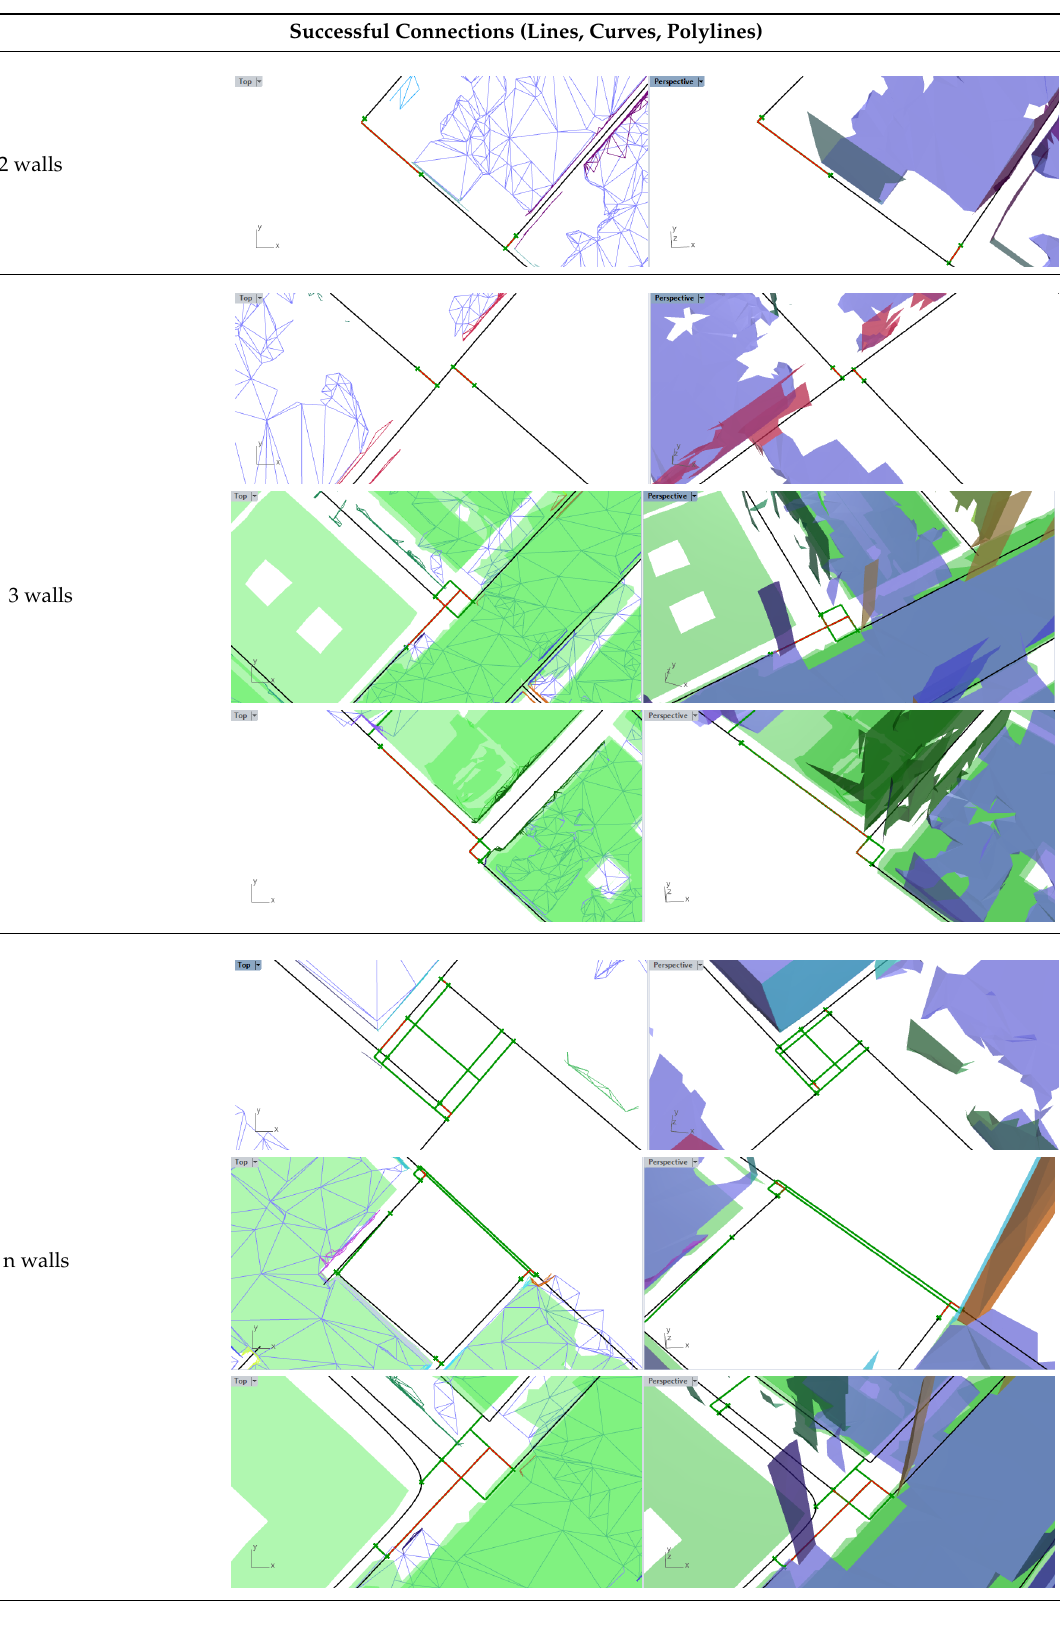
Detailed topology reconstruction results of interlocking walls in complex scenarios. Partial walls are shown in black, potential connection in green and final connections in red. The green surfaces depict the IfcSpace geometry and the floor segments are shown in